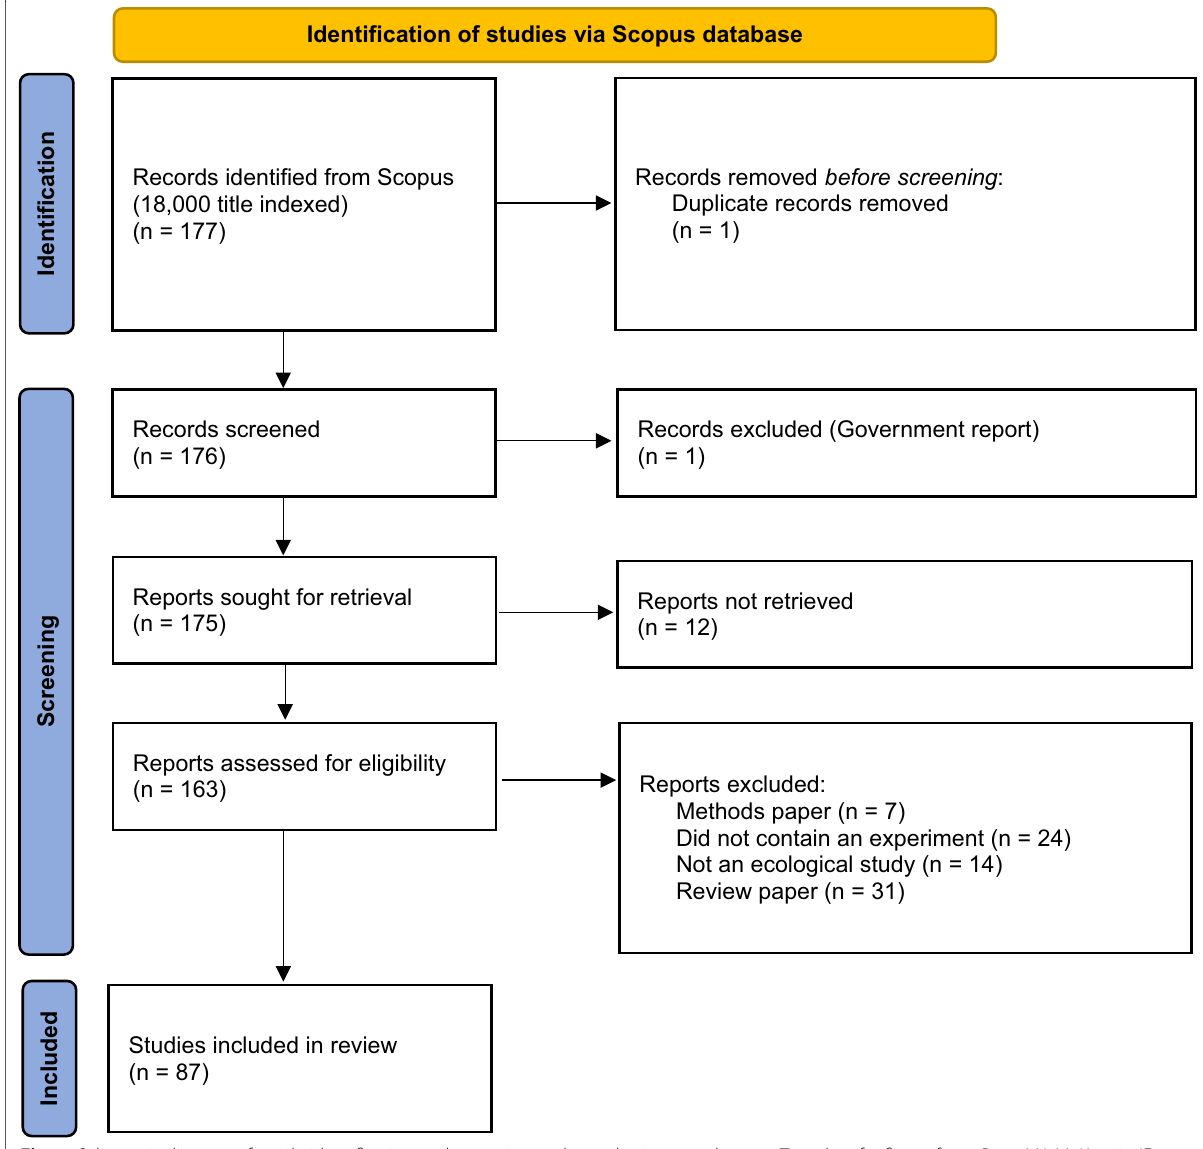
Fig. 1 Schematic diagram of article identification and screening and sample size at each stage. Template for figure from: Page MJ, McKenzie JE, Bossuyt PM, Boutron I, Hoffmann TC, Mulrow CD, et al. The PRISMA 2020 statement: an updated guideline for reporting systematic reviews. BMJ 2021;372:n71. https:// doi. org/ 10. 1136/ bmj.